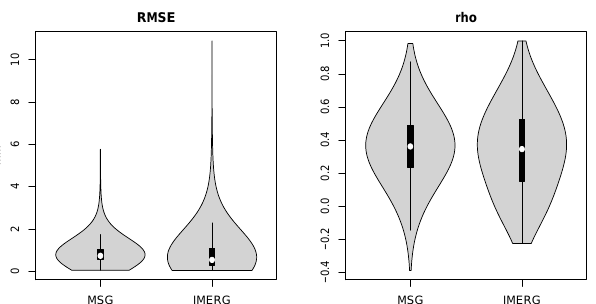
Figure 9. Comparison of the performance of the MSG-based re- trieval and GPM IMERG for hourly rainfall quantities between March and August 2014. Each of the data points is the average per- formance of 1h. See Fig. 3 for further information on the figure